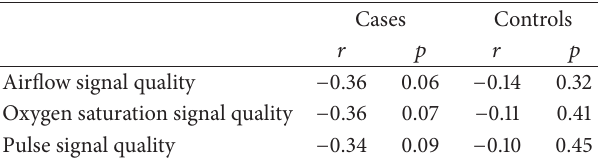
Table 4: Correlation of signals quality with age in PD patients and controls.